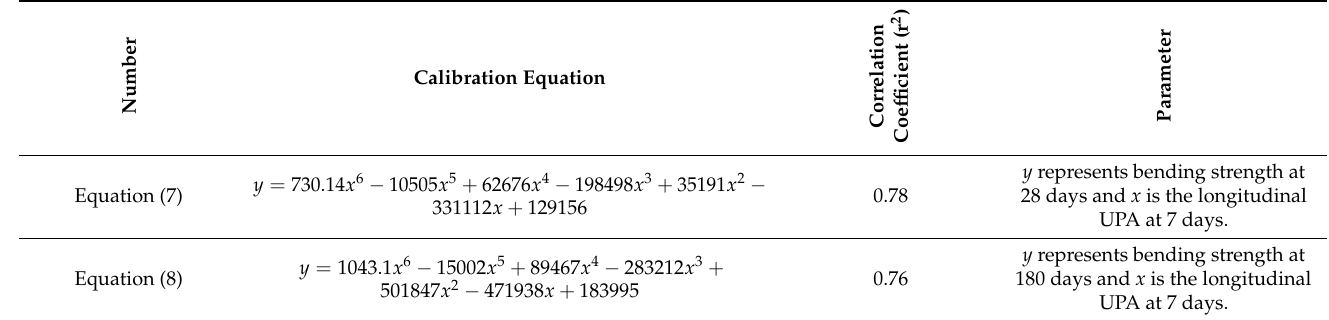
Table 6. Calibration equations for predicting bending strength from longitudinal UPA.